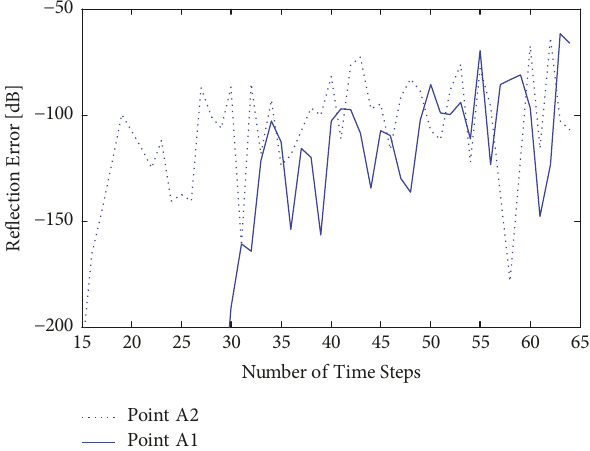
Figure 3: Reflection error of results of PML-ABC as a function of timestepwithd=2, 𝜎 𝑚𝑎𝑥 =2.6e-7, 𝑓 =1.88e+17(Hz),h=2.0e-5(m), Δ𝑡 = 4.34e-13(s), K=84, and varying m.